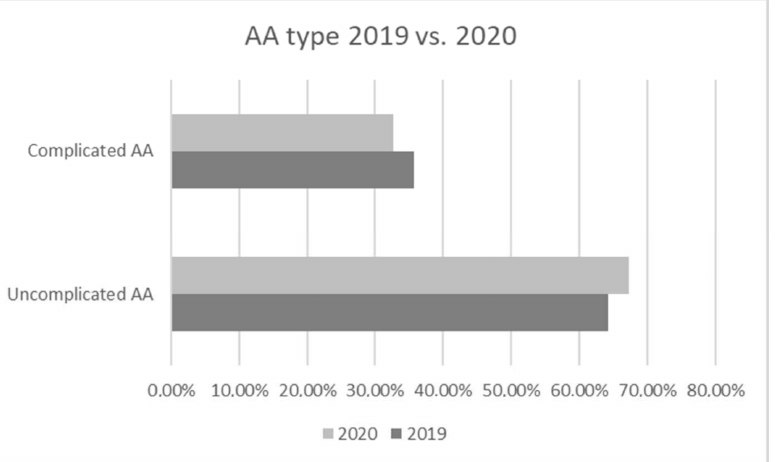
Figure 1. The rate of uncomplicated vs. complicated acute appendicitis(AA) during the pandemic (2020) and non-pandemic (2019)